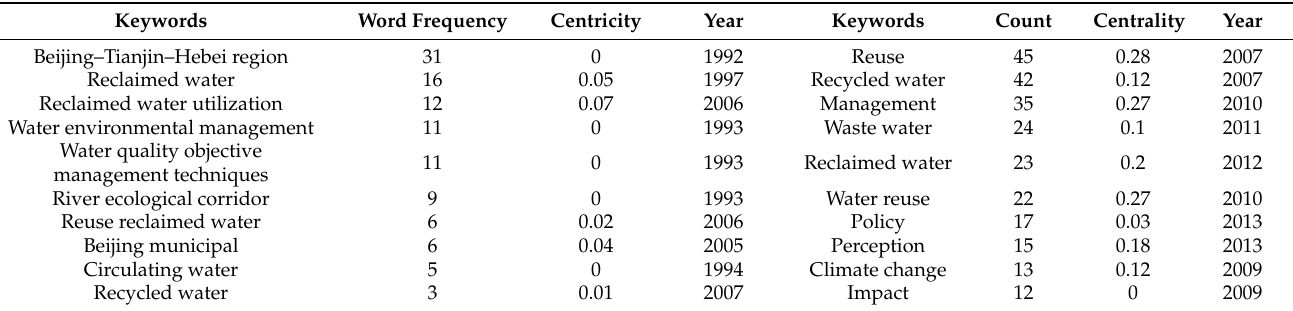
Figure 9. Cooccurrence of keywords in WOS. Table 4. Keyword frequency